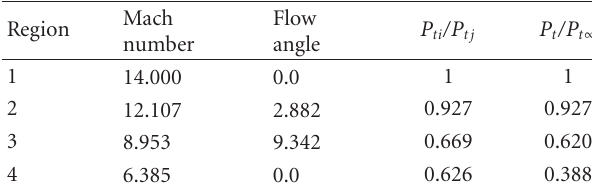
Table 1: Shock-canceled inlet flow conditions.